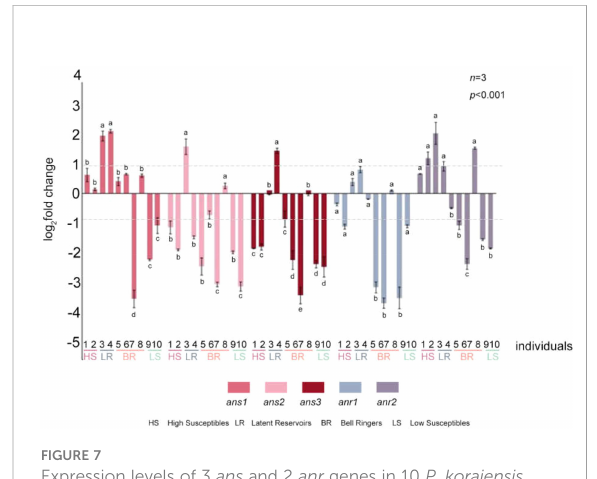
FIGURE 7 Expression levels of 3 ans and 2 anr genes in 10 P. koraiensis individuals at 12 hpi. Data were analyzed by one-way ANOVA followed by Tukey ’ s posthoc test, with different letters indicating statistically signi fi cant differences at 95% con fi dence. The data in the fi gure are means ± SE ( n =3). Letter a: the maximum average number marked with the letter a Letter b: The maximum average is compared with the following averages. Where the difference is not signi fi cant, the letter a is marked until a signi fi cant difference is marked with the letter b Letter labeling followed by analogy. Where there is an identically marked letter, the difference is not signi fi cant; where there are different marked letters, the difference is signi fi